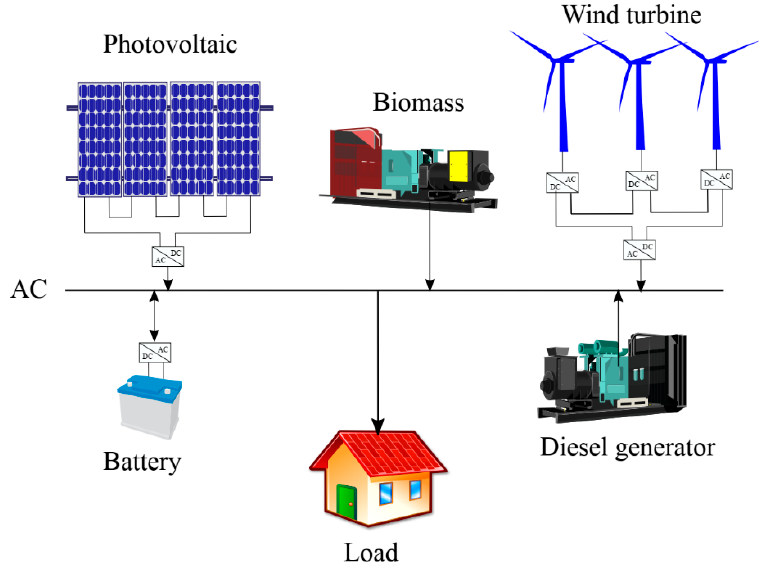
Figure 1. Configuration of the proposed microgrid hybrid energy system.